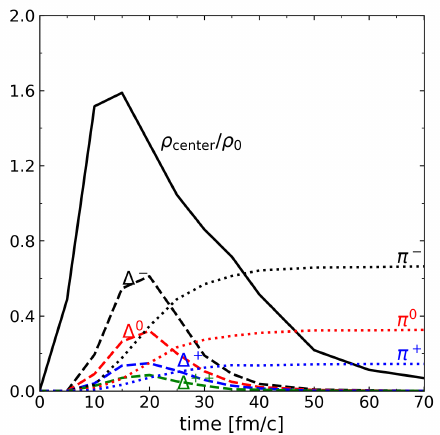
Figure 1. Central densities and number of ∆ resonances and pions as a function of time for case 4 in 132 Sn+ 124 Sn collision system. We have similar trend for other three sets ( case 1, case 2, and case 3) (not